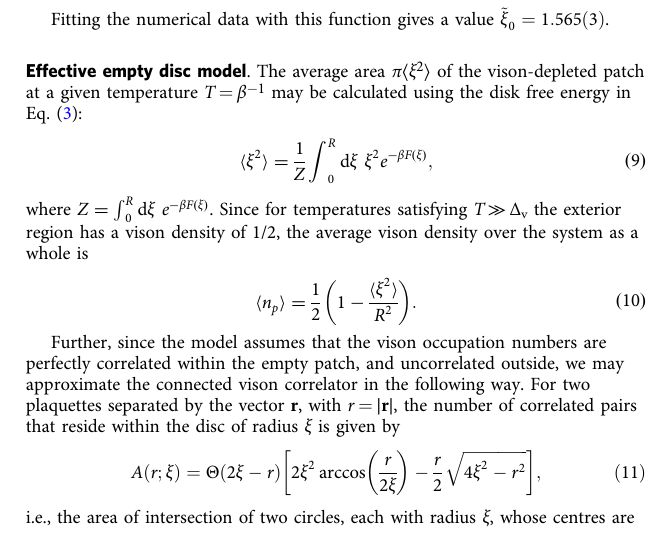
The resulting ground state energy of the spinon is then averaged over the exterior vison con fi gurations. The resulting averaged energy is plotted in Fig. 5, and a fi t to Eq. (6) is performed, leading to the value ξ 0 = 1.64(2). This value does not exhibit signi fi cant variation with system size L .